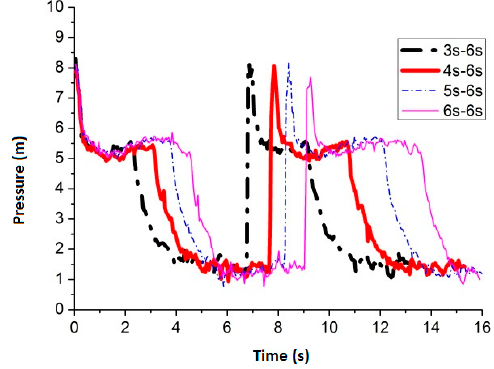
Figure 13. The four best pressure values (rectangular nozzle in the middle of the pipe).